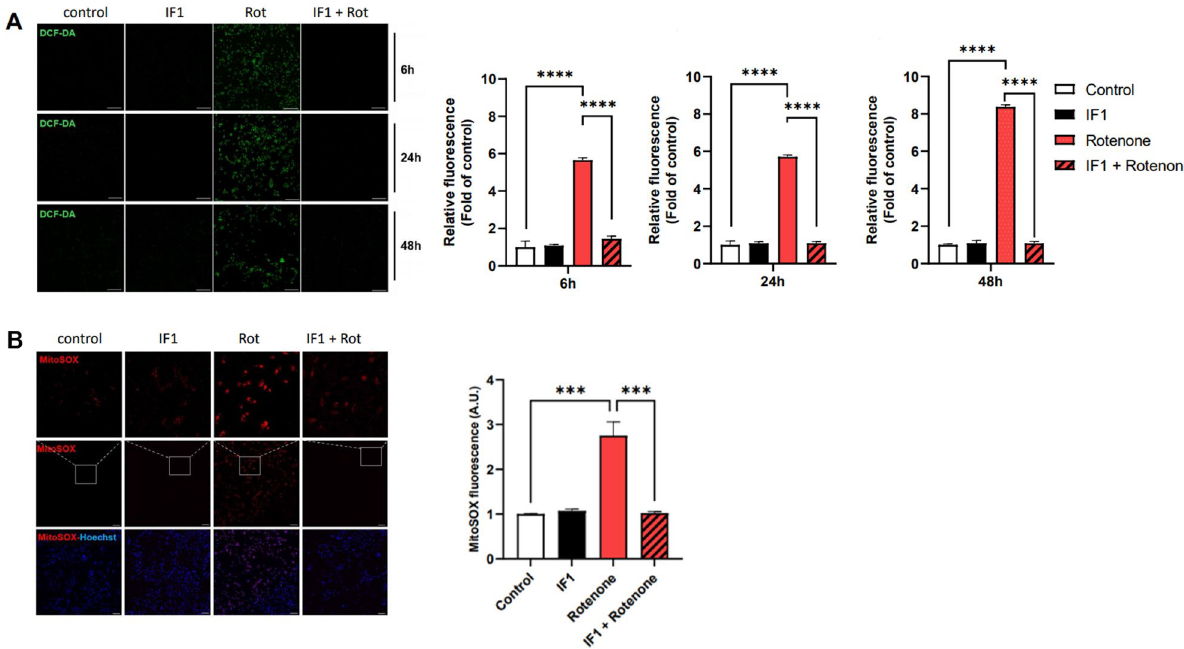
Figure 2. Treatment with IF1 prevents rotenone-induced ROS generation in SH-SY5Y cells. SH-SY5Y cells were treated with 1 µM rotenone, 100 nM IF1, or a combination of both. ( A ) Representative images of ROS level using DCF-DA in cultured SH-SY5Y cells (right panel) and quantification of fluorescence was analyzed at 6 h, 24 h, and 48 h (left panel). Scale bar = 200 μm. ( B ) Representative confocal images of mitoSOX staining in SH-SY5Y cells (left pane) and fluorescence were quantified (right panel). Scale bar = 200 μm. Data are expressed as mean ± SEM, n = 3. **p < 0.01, ***p < 0.001, ****p < 0.0001. One-way ANOVA with a Tukey’s post-hoc